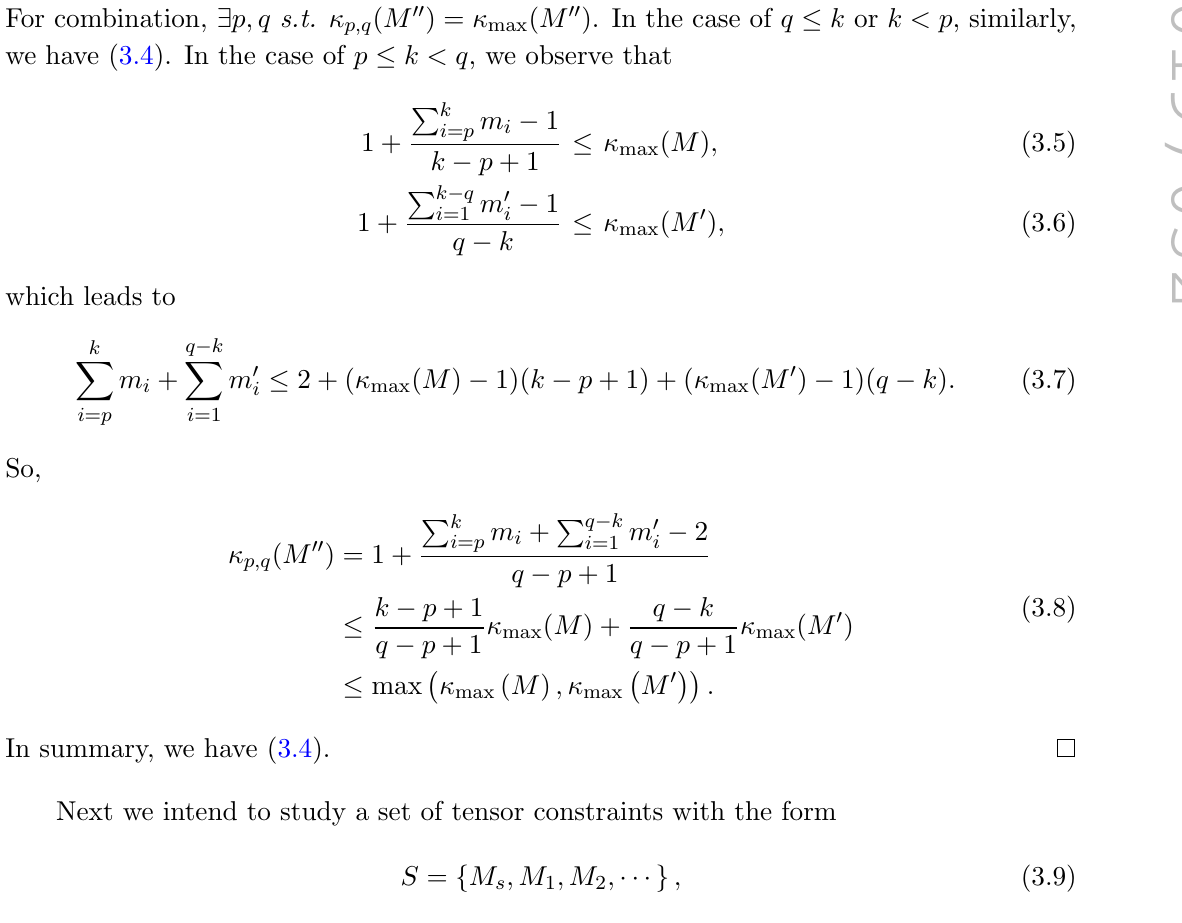
h 0 1 1 i 4 3 3